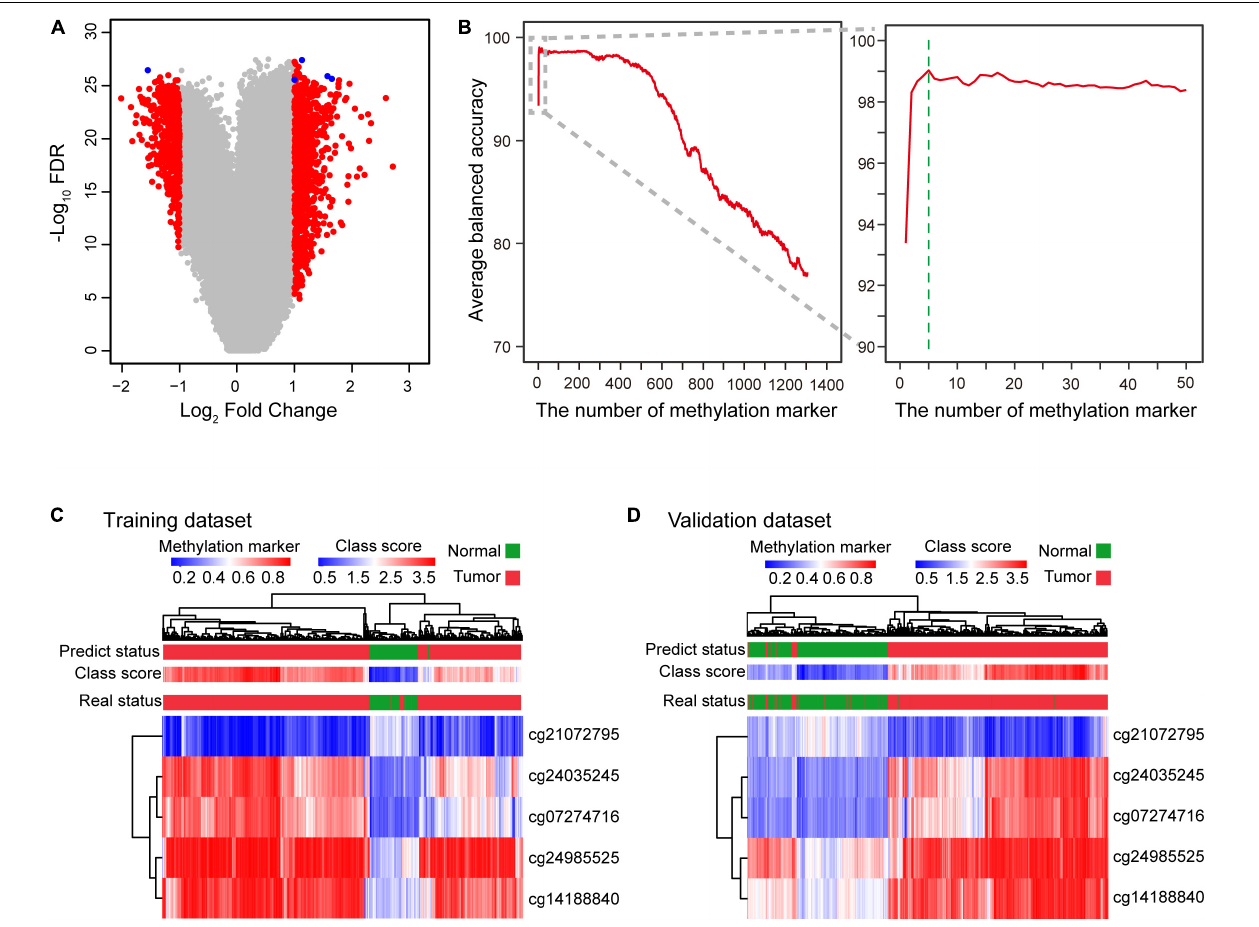
FIGURE 1 | Construction of the diagnostic signature consisting of five DNA methylation markers. (A) Five DNA methylation markers were selected to construct the diagnostic signature. Volcano plot showing the biological significance (log 2 fold change (FC)) on the X axis and the corresponding statistical significance ( − log 10 false discovery rate (FDR)) on the Y axis of markers between HCC patients and normal controls. A total of 1306 candidate markers (red and blue) were initially selected, with five markers (blue) finally selected to construct the diagnostic signature. (B) Curve of average balanced accuracy with increasing number of methylation markers. The green dotted line indicates that the diagnostic signature with five DNA methylation markers has the highest average balanced accuracy for sampling 100 times. (C,D) Heatmap of five DNA methylation markers selected to construct the diagnostic signature for the training (TCGA) (C) and validation (D) datasets (GSE54503, GSE56588, GSE60753, GSE75041, GSE77269, and